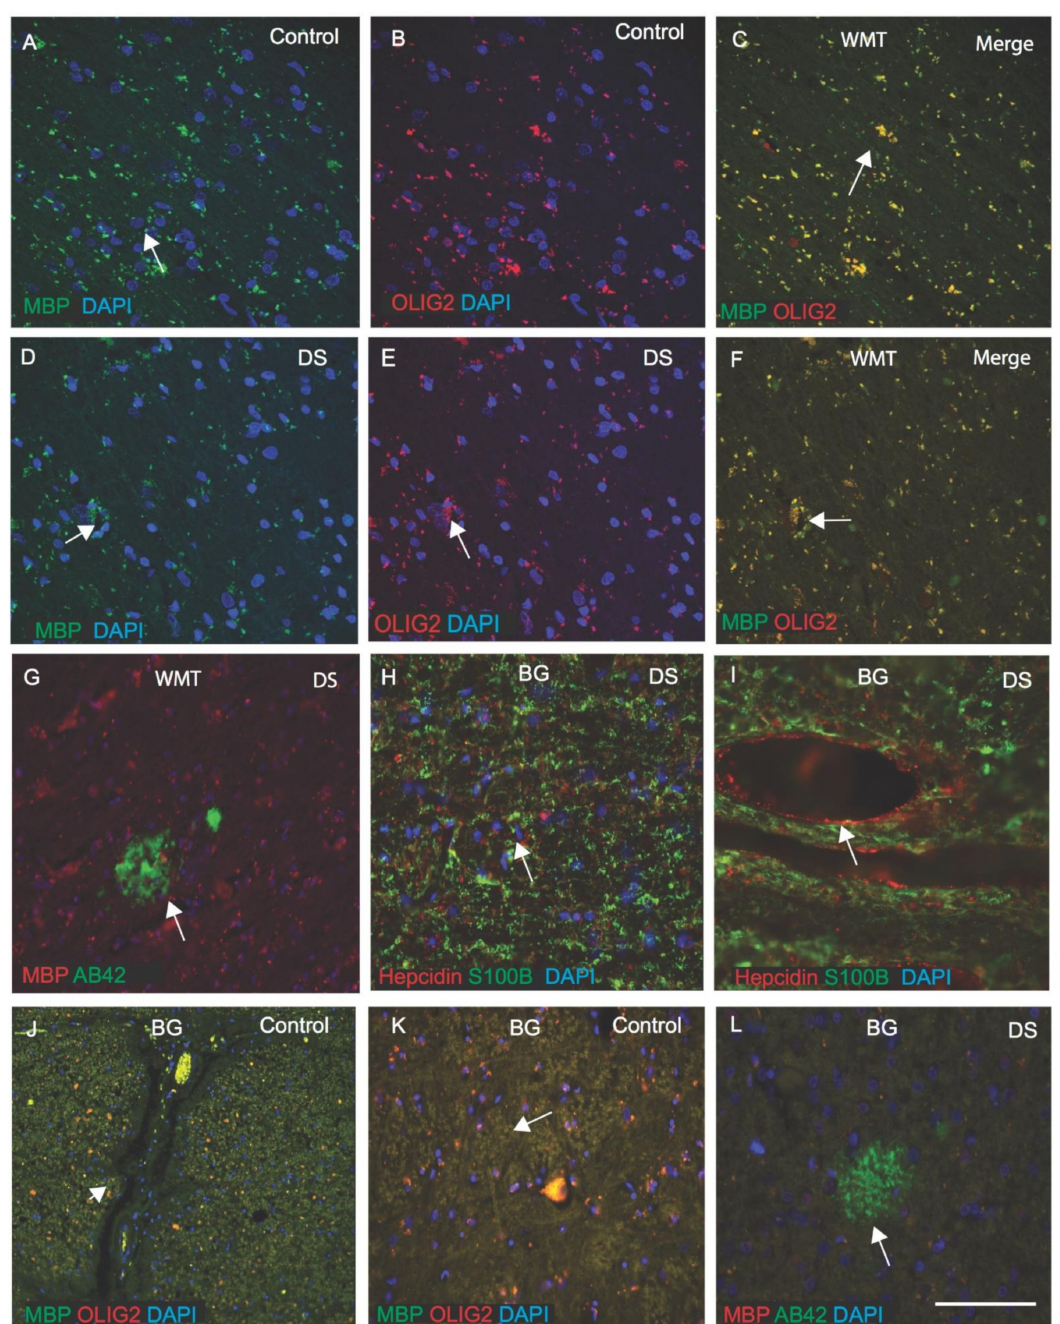
Figure 6. OLIG2 defect impairs myelination in DS brain . For DS and control white matter (WM) in the cortex and in